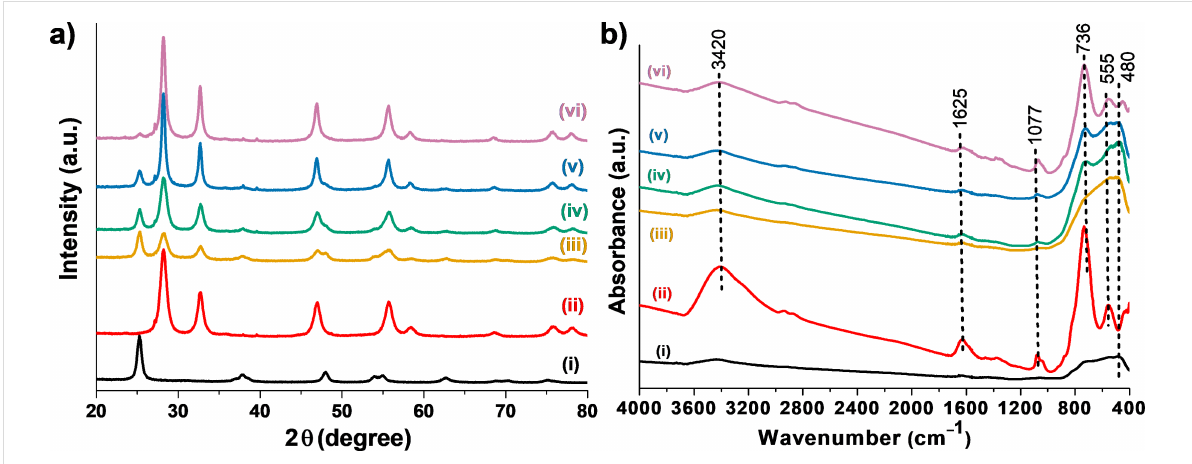
Figure 2: (a) XRD patterns and (b) FTIR spectra of (i) pure TiO 2 -NT and (ii) pure Bi 2 WO 6 samples, as well as of hierarchical (iii) 30% − Bi 2 WO 6 /TiO 2 - NT, (iv) 50% − Bi 2 WO 6 /TiO 2 -NT, (v) 70% − Bi 2 WO 6 /TiO 2 -NT, and (vi) 90% − Bi 2 WO 6 /TiO 2 -NT